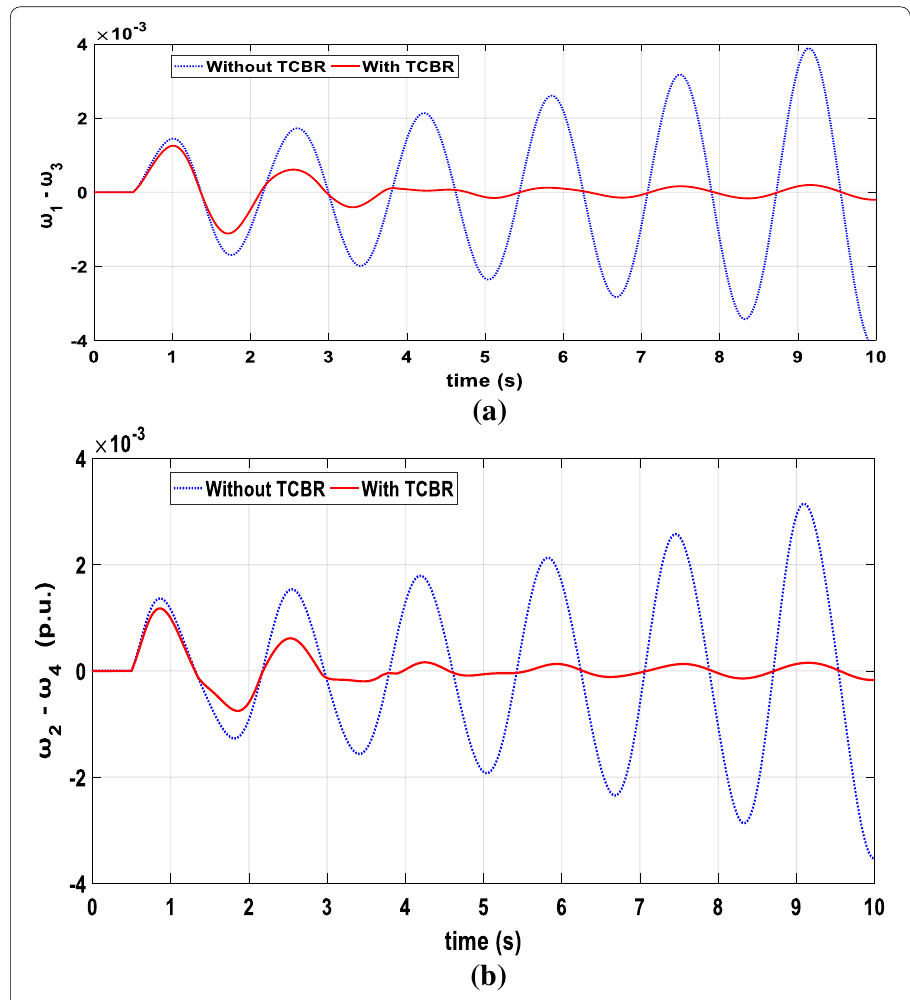
Fig. 9 Case (2) relative generator speeds time‑domain responses, a outer generators relative speed (ω 1 − ω 3 ) in (p.u.), b inner generators relative speed (ω 2 − ω 4 ) in